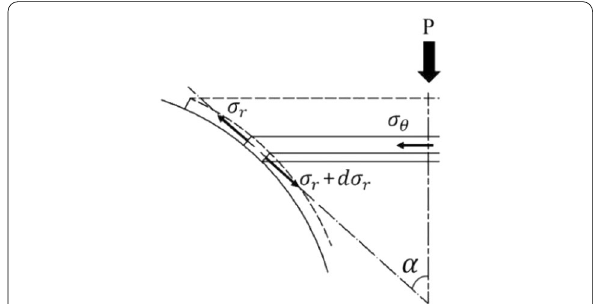
Figure 14 Scheme of radial stress occurring in the workpiece during the 1 st deep